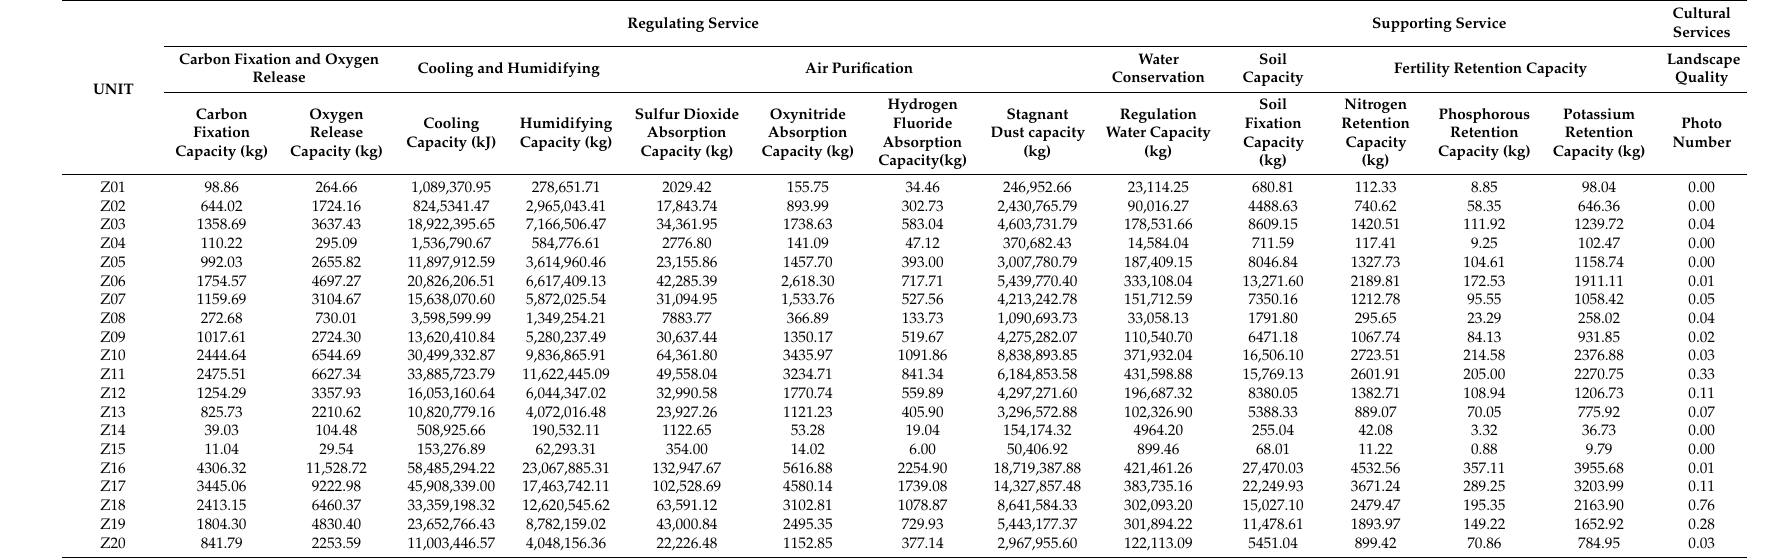
Table 3. Quality of ecosystem services of unit areas of research